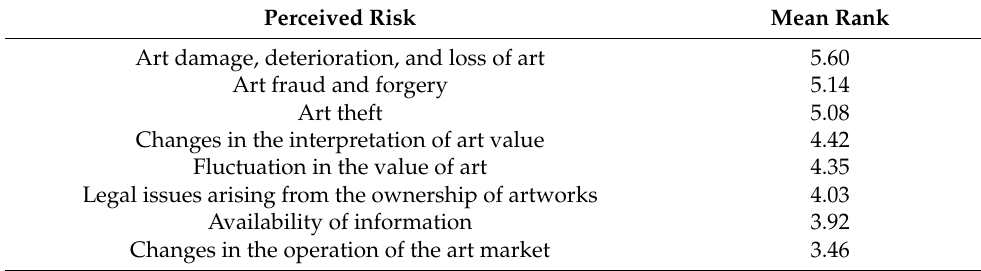
Table 6. Risk perception ranking.